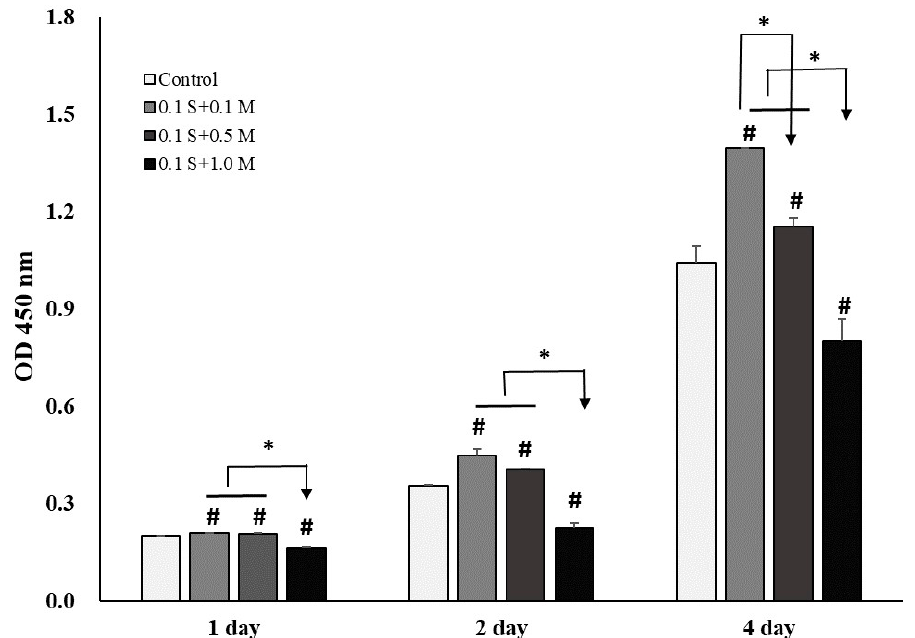
Figure 5. Cell proliferation based on the ratio of the sericin and MSM blends using L929 fibroblast. Cells were treated with 1.0 (0.1S + 0.1M), 5.0 (0.1S + 0.5M), and 10.0 (0.1S + 1.0M) mg/mL MSM at 1.0 mg/mL sericin. All values are presented as the mean ± standard deviation (n = 3). # p < 0.05 vs. CON. * p < 0.05.